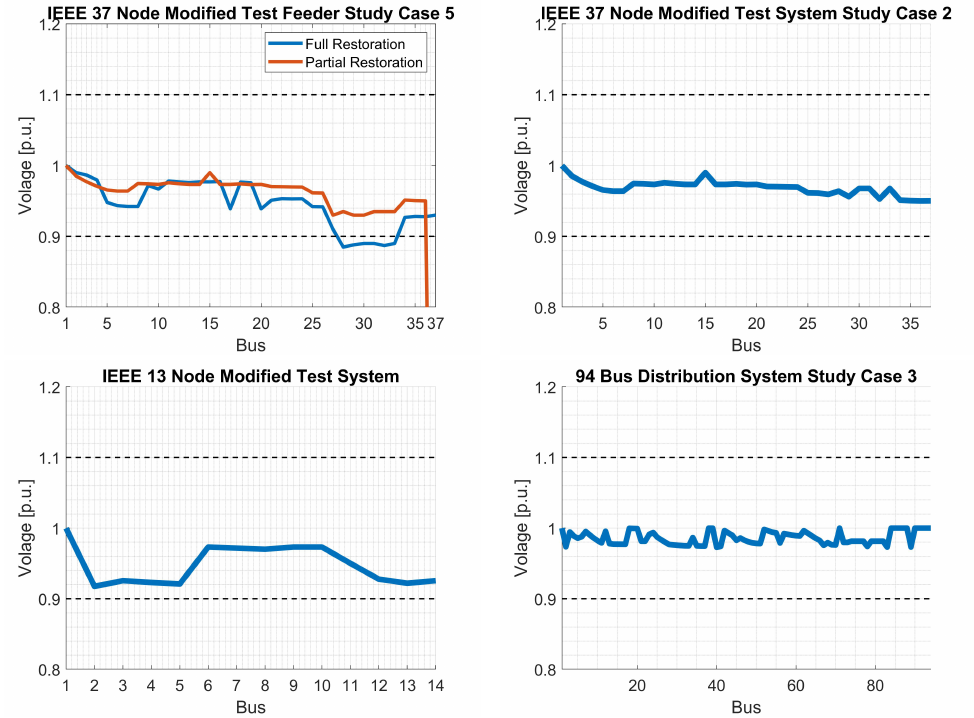
Figure 9. Full restoration voltage